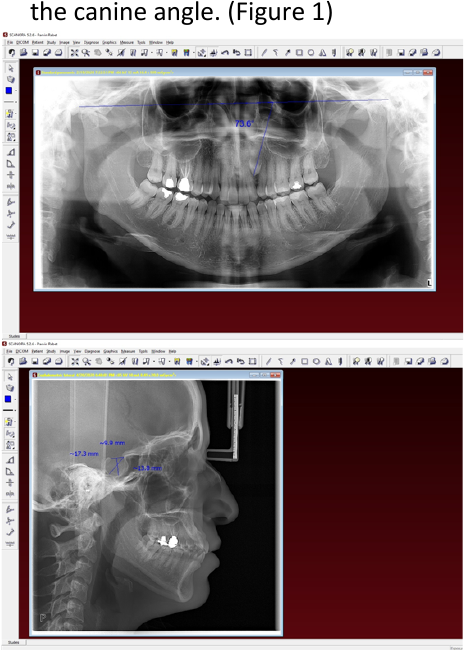
Figure 2. Examples of different types of Sella